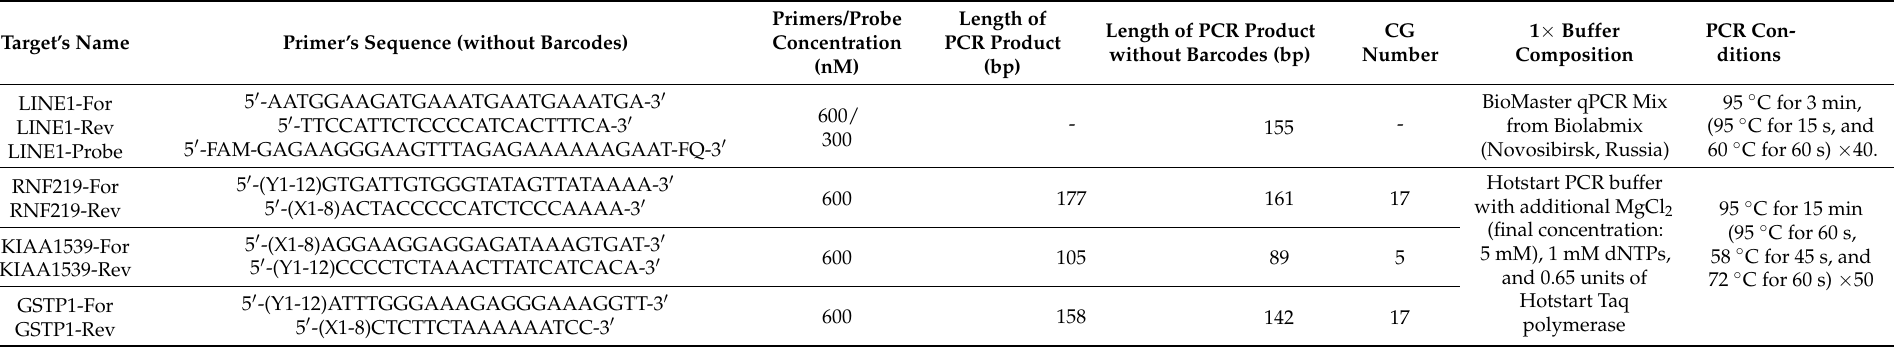
Table 2. PCR conditions and primers’